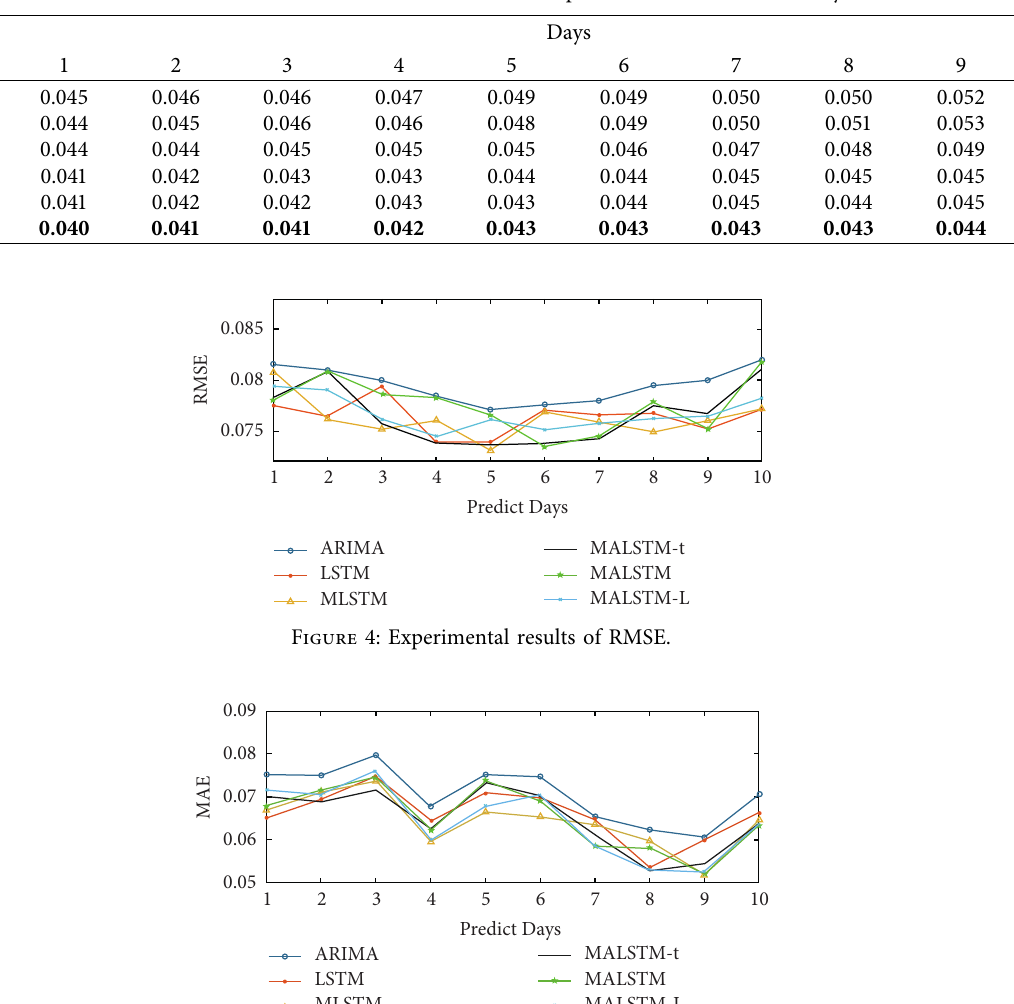
Table 2: The MAE results of the market amount prediction in the next ten days.